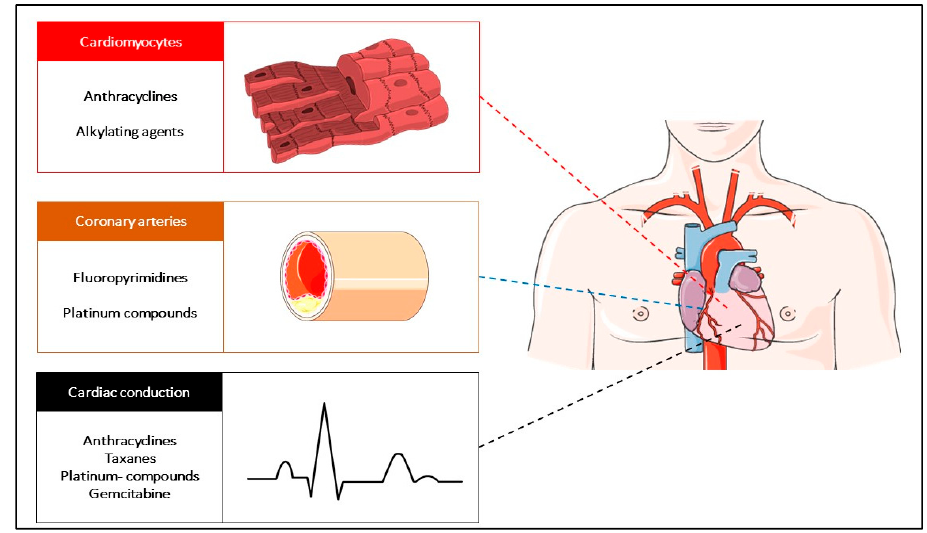
Figure 1. The spectrum of cardiac toxicity and the most common related causative antineoplastic agents.